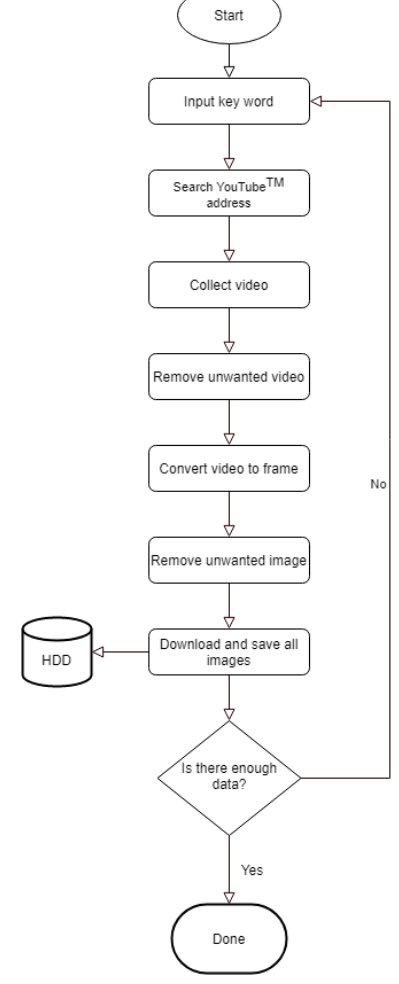
Figure 2. Image dataset collection process.